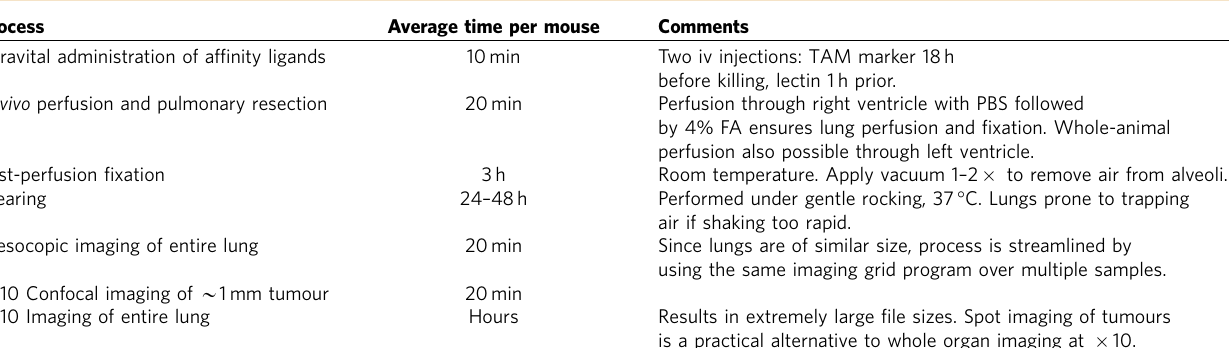
Table 2 | Overview of times required for different experiments steps.